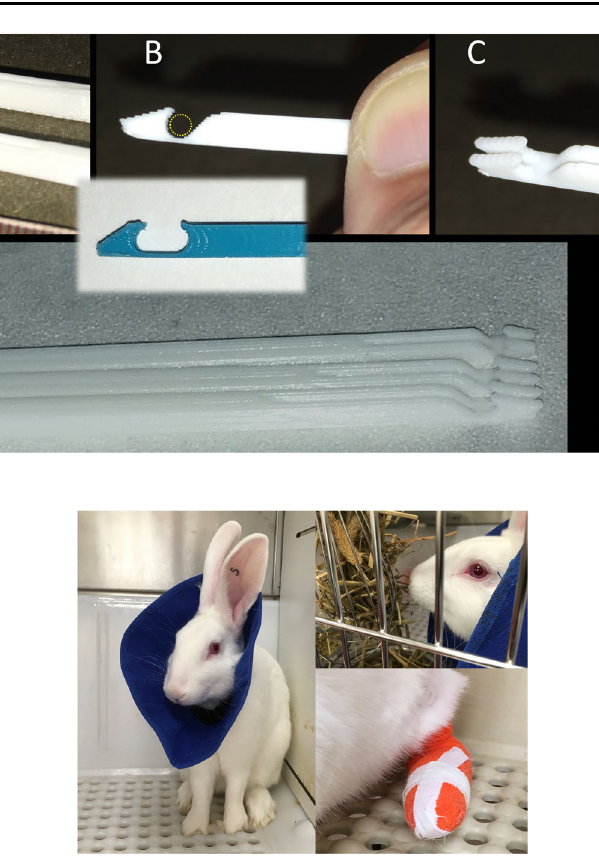
Fig. 3 A combined approach to prevent self-mutilation and/or treat its consequences was based on: (1) a training of the rabbits to continue their daily activities while wearing a soft Elizabethan (e-collar); (2) bandaging the surgical limb with tape stirrups